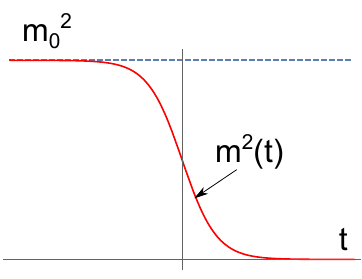
Figure 1 . Mass quench from m 0 to